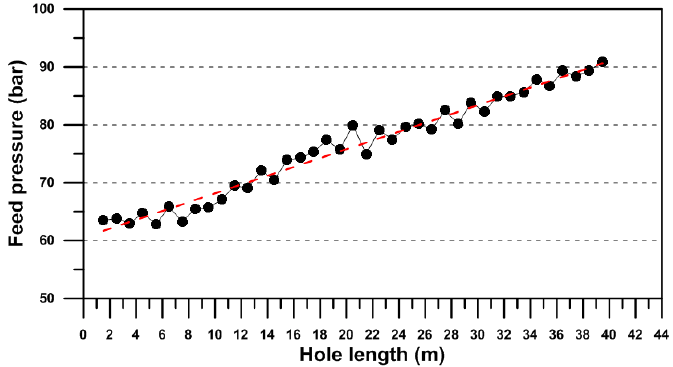
Figure 4. Penetration rate versus hole length.